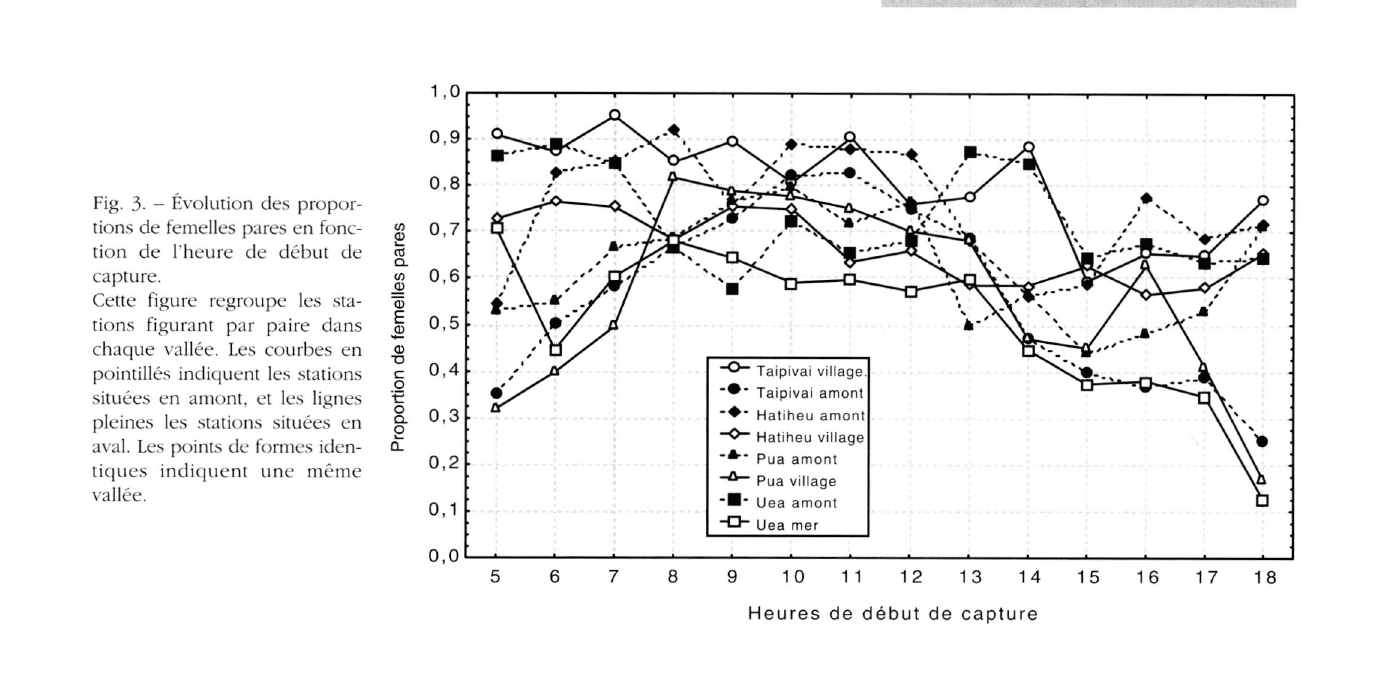
Fig. 3. - Évolution des propor tions de femelles pares en fonc tion de l'heure de début de